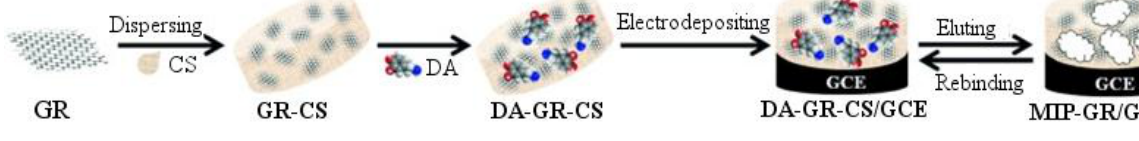
Figure 8. Preparation of MIPs-RGO/CS and its recognition for